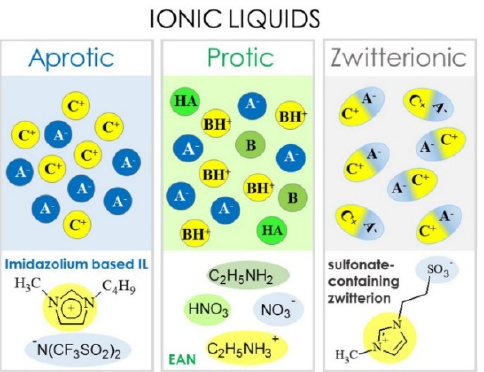
Figure 1. Classification of ILs: aprotic-, protic-, and zwitterionic-type. (A − : anion, B: base, C + : cation, BH + : Brønsted base, HA: Brønsted acid) Reprinted 2015 from [60] with permission from IOP Publishing.